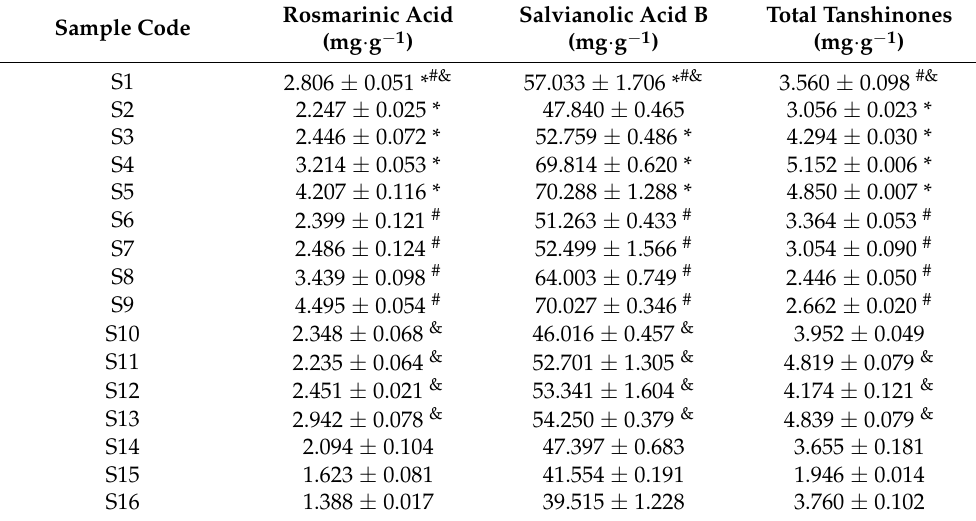
Table 1. Contents of six active ingredients in